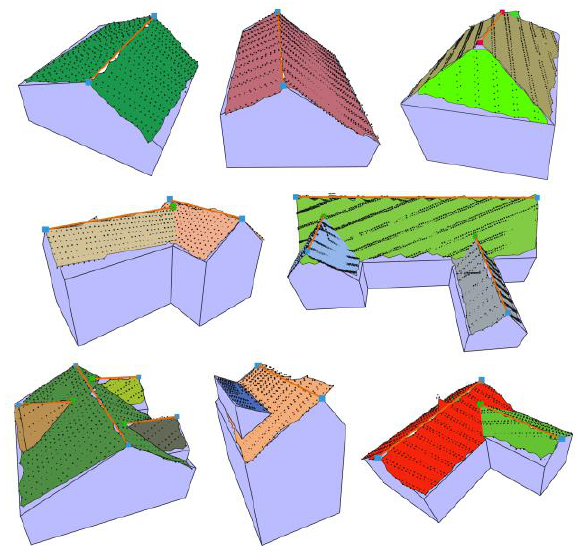
Figure 9. Reconstructed 3D building models overlaid with the point segmentation and their semantic features (orange line = ridge, blue = gable end, red = hip end, green = ridge